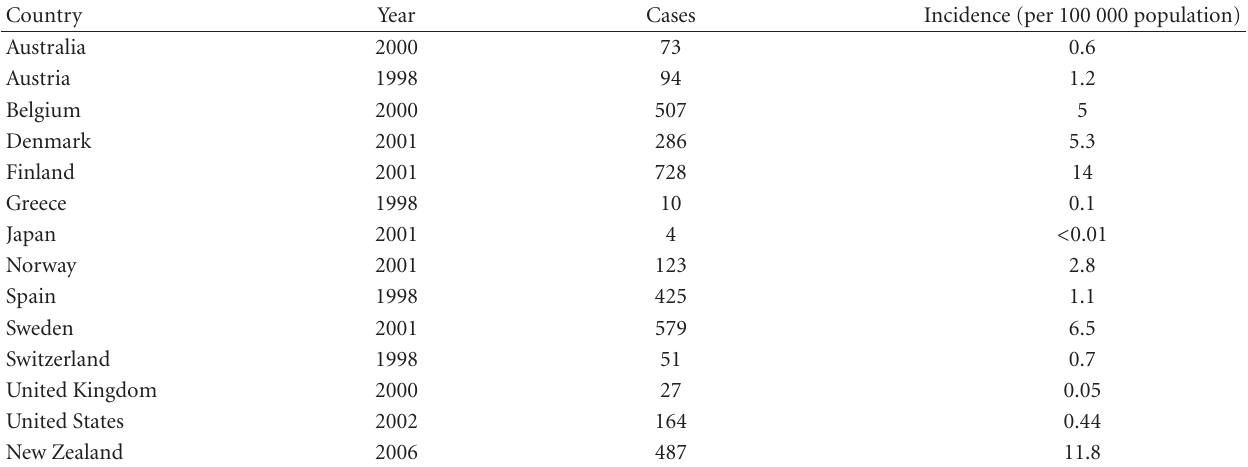
Table 4: Annual incidence of disease caused by foodborne bacterial agents in di ff erent